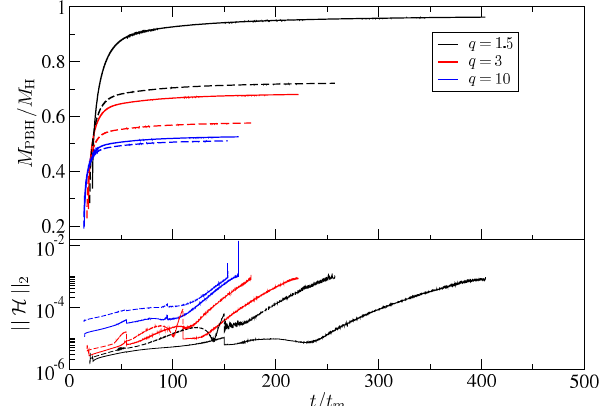
Figure 18. ( Top-panel ): Evolution of M PBH ( t ) for the profiles q = 1.5, q = 3, and q = 10. The dashed line corresponds to Equation (83) with λ = 0 and the solid line to Equation (82). ( Bottom-panel ): Time evolution of the Hamiltonian constraint. In all cases, δ m − δ c = 5 × 10 − 3